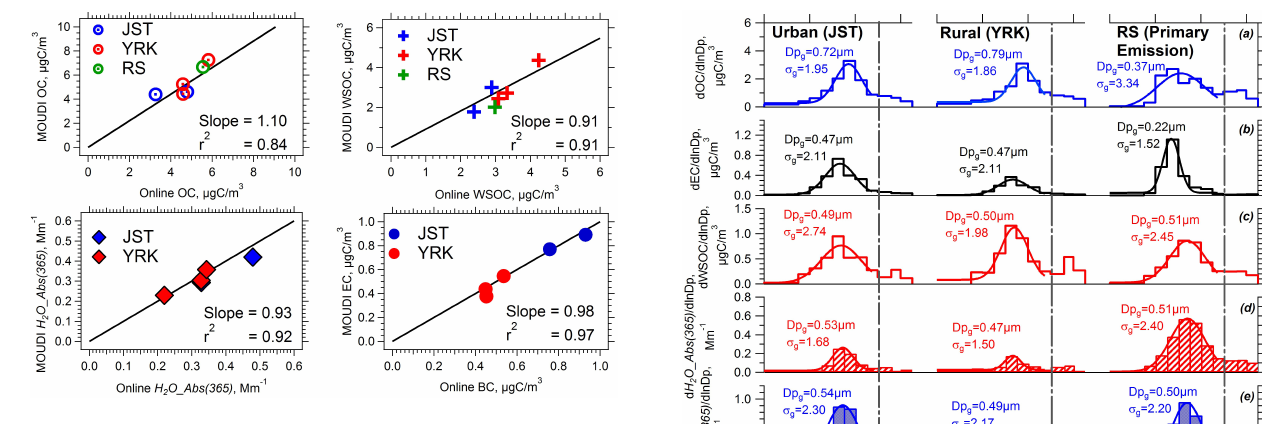
Fig. 2. Comparison of offline fine particle MOUDI OC, EC, WSOC, water-extracted absorption at 365nm and online OC, BC, WSOC, and water-soluble absorption at 365nm using orthogonal distance regressions with slopes forced through zero. Online data are PM 2 . 5 and MOUDI summed over all stages of 3.1µm cut and below (plus after filter). The sites are JST (urban), YRK (rural) and RS (road- side). No online H 2 O Abs or BC was available at the RS site during the MOUDI sampling period.